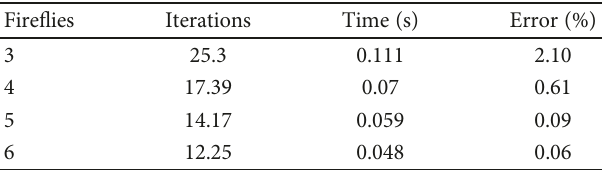
Table 7: Parameter settings of the GA, FA, and the proposed